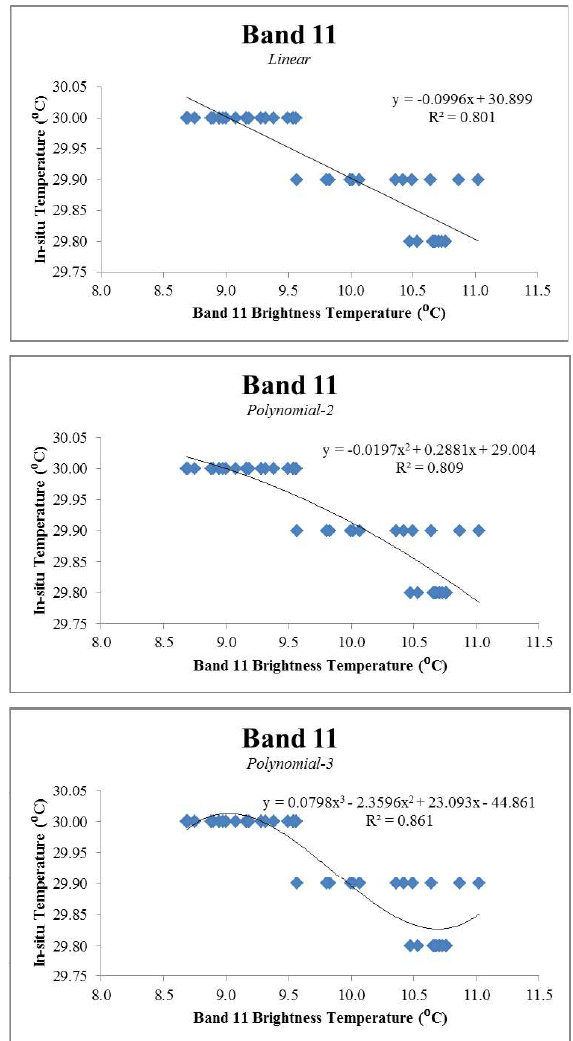
Figure 5. Relation of band 11 BT and Measured Sea Surface Temperature